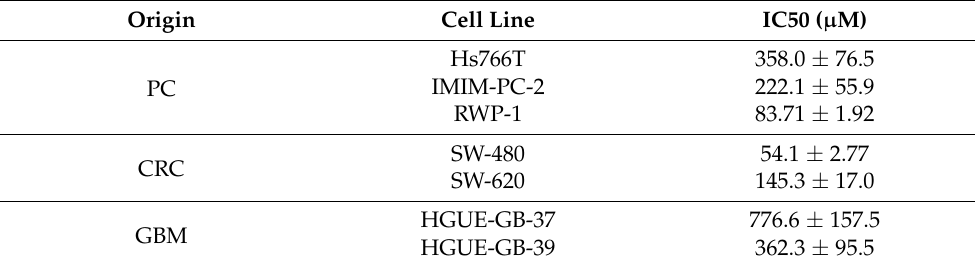
Table 3. IC50 value of H 2 O 2 on pancreatic carcinoma (PC), colorectal carcinoma (CRC) and glioblas- toma (GBM) cell lines. Cells were treated with a concentration range between 50 and 600 µ M H 2 O 2 for 72